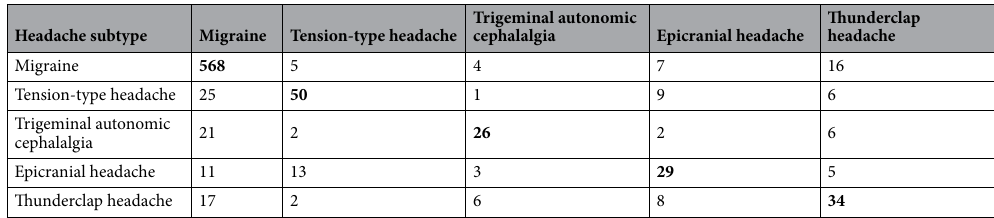
Table 5. Confusion matrix for the test cohort. The bold numbers in the main diagonal denote correctly classified subjects.